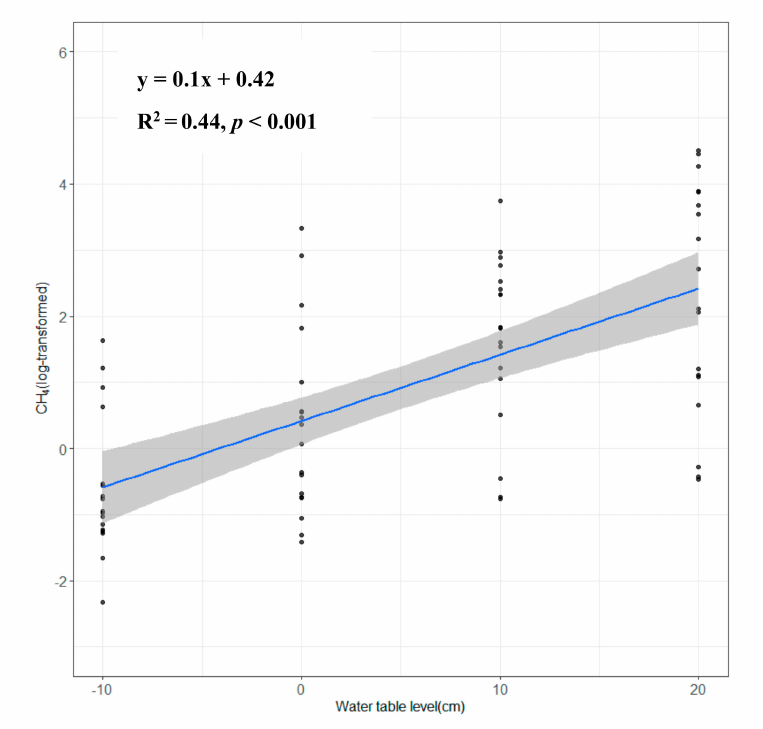
Figure 4. Relationships between water table levels and CH 4 emissions; x represents the water table level and y represents the log-transformed CH 4 emissions. The blue line and grey region indicate the regression line and 95% confidence interval,